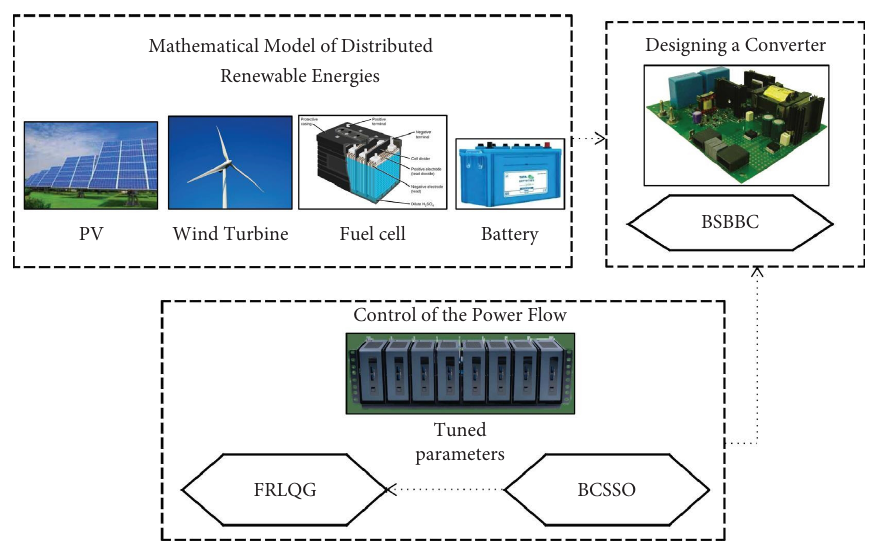
Figure 1: Block diagram for the proposed research